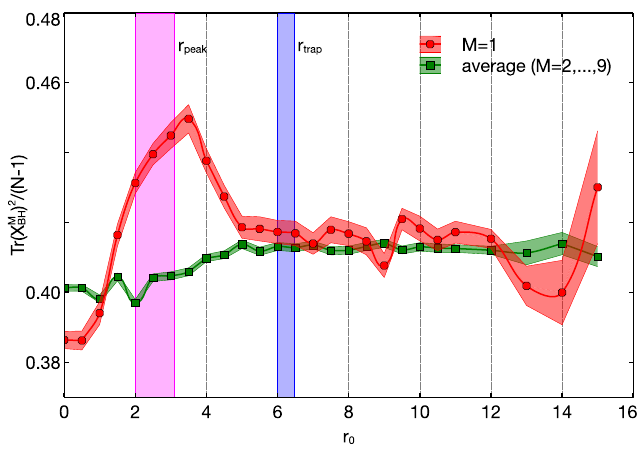
Figure 5 . The squared radius of the bunch in the direction of the probe r 2 h 1 Tr( X 1 ) 2 i (red) and the squared radius averaged over the eight orthogonal directions, BH ( N (cid:0) 1) P 9 r 2 = h 1 Tr( X M ) 2 i (green) as a function of the probe position r 0 . The radius average BH M =2 8( N (cid:0) 1) of the bunch in M=1 is larger than the one in the orthogonal directions once the probe enters r trap and grows to a maximum near r peak . r trap and r peak are indicated by vertical colored bands, while r 2 and r 2 are shown with error bands representing statistical uncertainties of the Monte average M=1 Carlo simulations. The data is for N = 12, L = 10 and T = 2 : 0, but similar features are present for all parameters N , L and T that we studied. The larger error bands on the M = 1 direction compared to the orthogonal direction re(cid:13)ects the fact that there are 8 orthogonal directions so we e(cid:11)ectively get a larger statistical sample for the orthogonal